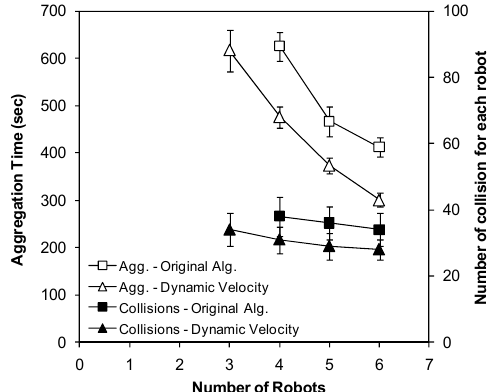
Fig. 11. Aggregation time and number of collision for BEECLUST and dynamic velocity algorithms